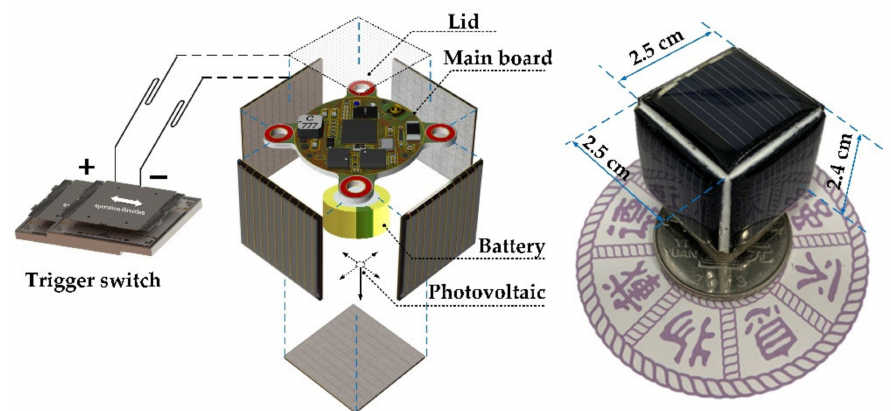
Figure 5. Structure and components of the microsystem.